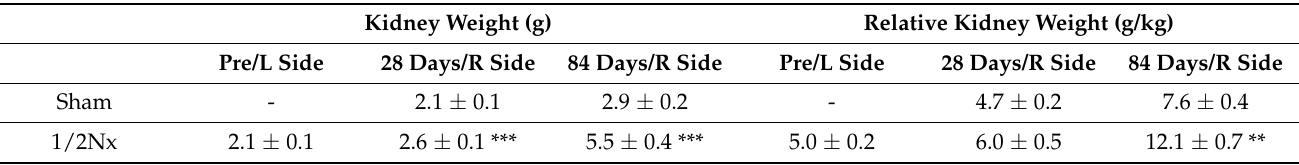
Table 1. Kidney weights before surgery (Pre) and 28 and 84 days after surgery in Sham operated and 1/2Nx DEK rats.